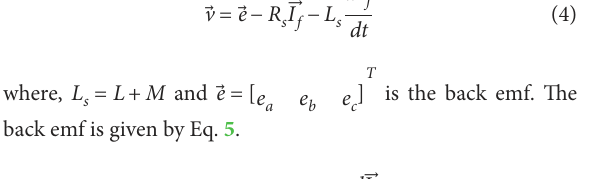
generator and that the stator winding has a self-inductance of L , mutual inductance of M , and resistance R winding. The electromagnetic flux ( Φ ) produced by the stator winding and the current ( i ) flowing through the winding can be represented by Eq. 2